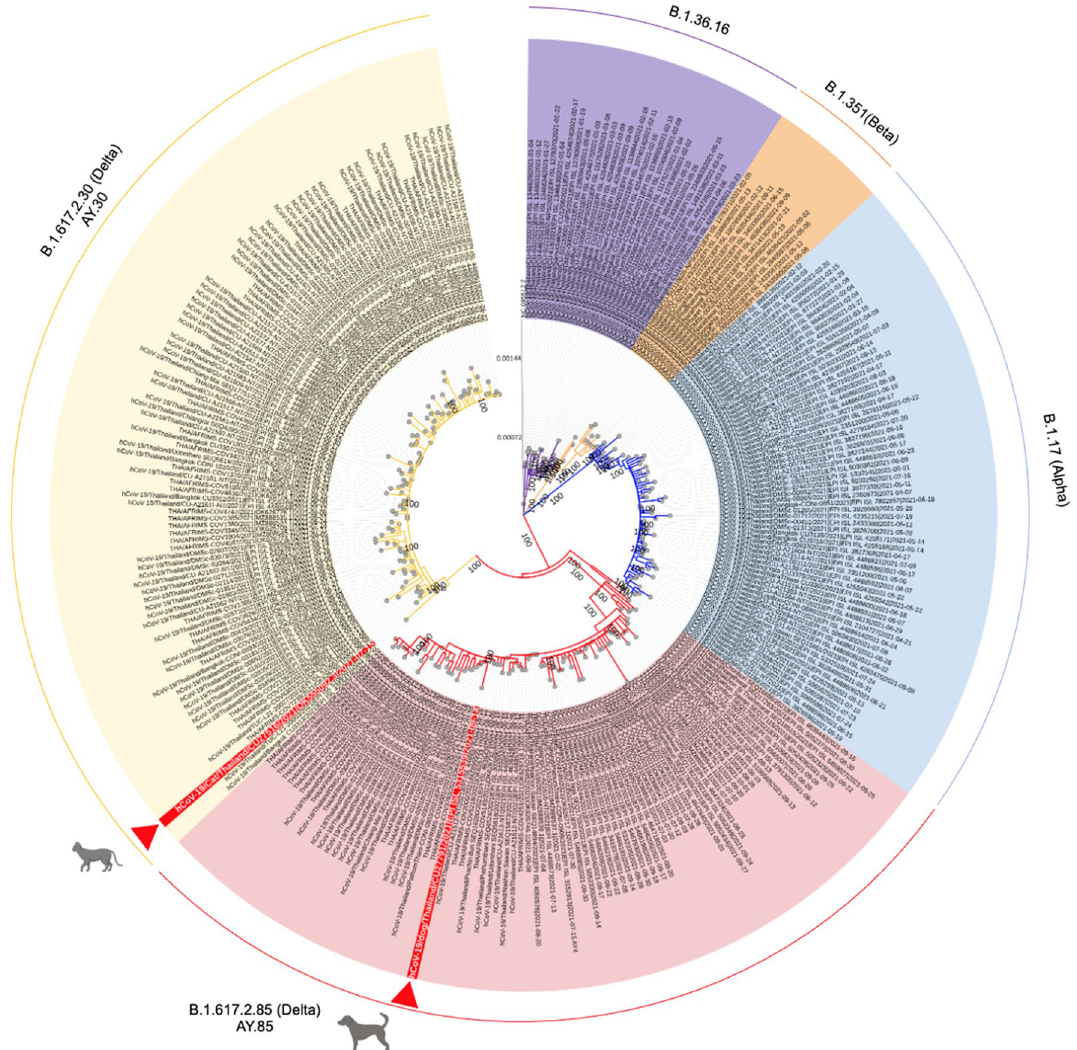
Figure 2. The maximum likelihood tree of SARS-CoV-2 from dog, cat and human from Thailand. Tree was constructed by using IQ-TREE version 2.1.3 (http:// www. iqtree. org/) using the GTR + Γ model of nucleotide substitution, default heuristic search options, and ultrafast bootstrapping with 1000 replicates. Tree was visualized by iTOL version 6.0 (https:// itol. embl. de/). Colors indicate PANGO lineages including purple (B.1.36.16), orange (B.1.351; Beta), blue (B.1.1.7; Alpha), pink (B.1.617.2.85; Delta AY.85) and yellow (B.1.617.2.30; Delta AY.30). Red arrows indicate SARS-CoV-2 from dog and cat in this